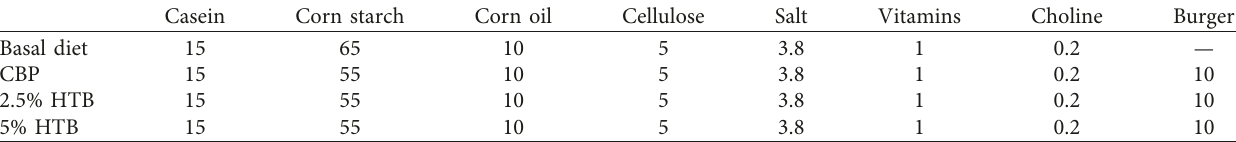
Table 1: Composition of the experimental diets.